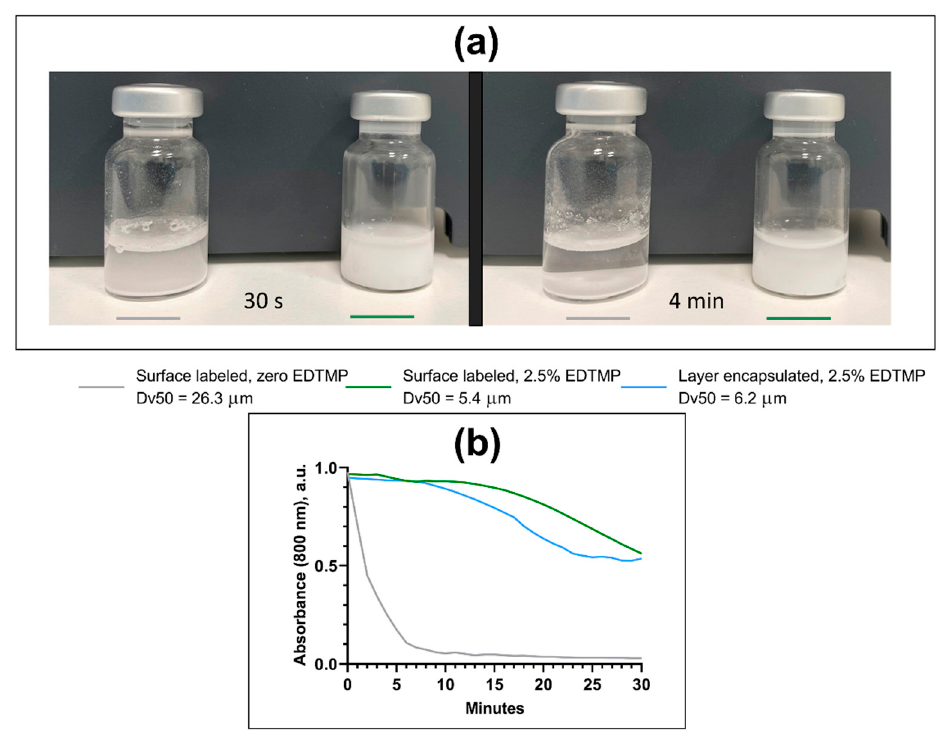
Figure 3. Sedimentation rate of nonradioactive autoclaved CaCO 3 microparticles of different sizes. ( a ) Comparison of mock surface-labeled MPs suspended in 0.9% NaCl with and without EDTMP, after the suspension was allowed to sit for 30 s and 4 min, respectively. ( b ) Assessment of the turbidity of suspended CaCO 3 MPs of different sizes, all mock surface-labeled, and layer-encapsulated MPs are indicated by the blue line. Dv: volumetric diameter, with Dv50 being the 50th percentile.